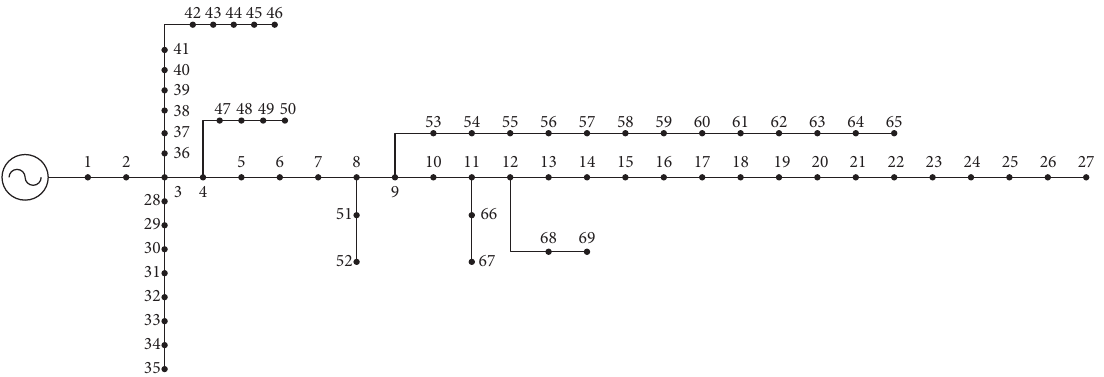
Figure 3: IEEE 69-node distribution